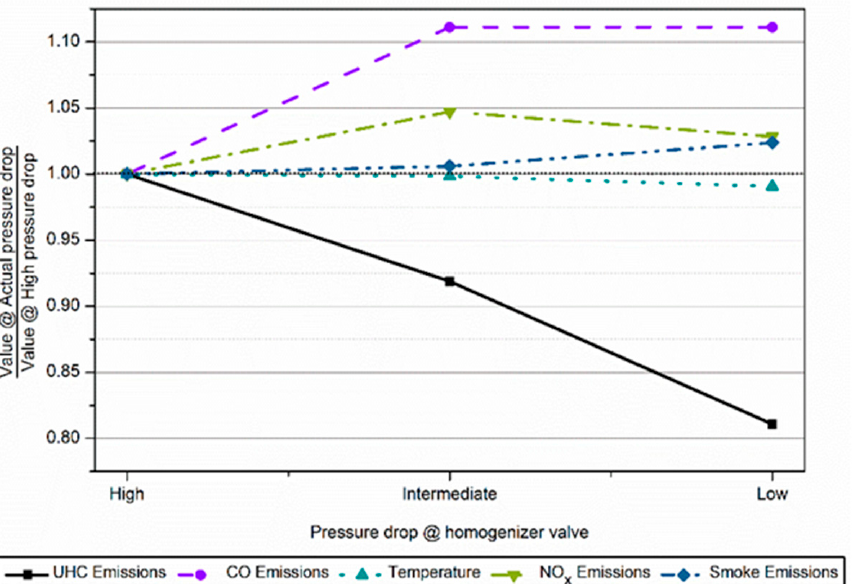
Figure 8. Dimensionless change of temperature and emissions of smoke, NO x , CO and UHC as a function of pressure drop on the homogenizer for FWE containing 9.09% water and 1.82% emulsi- fier.